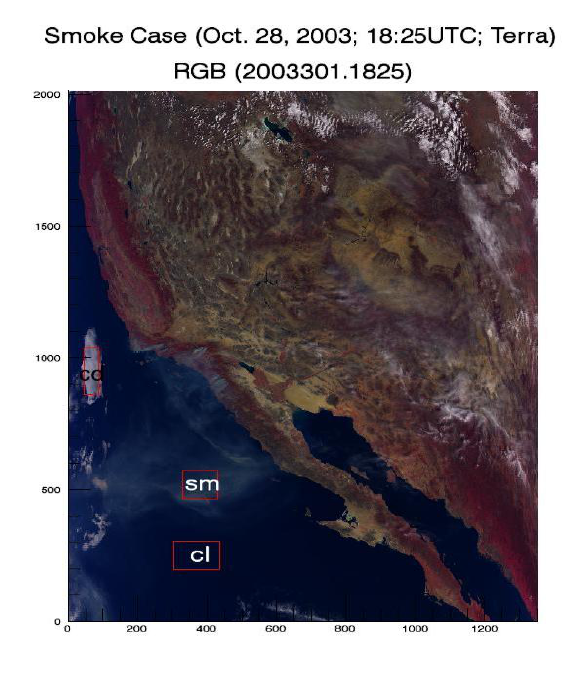
Figure 10. Terra MODIS RGB image for a granule with smoke plume over ocean. Three rectangle regions influenced, respectively, by cloud (cd), clear-sky (cl), and smoke (smoke) are selected for sensitivity